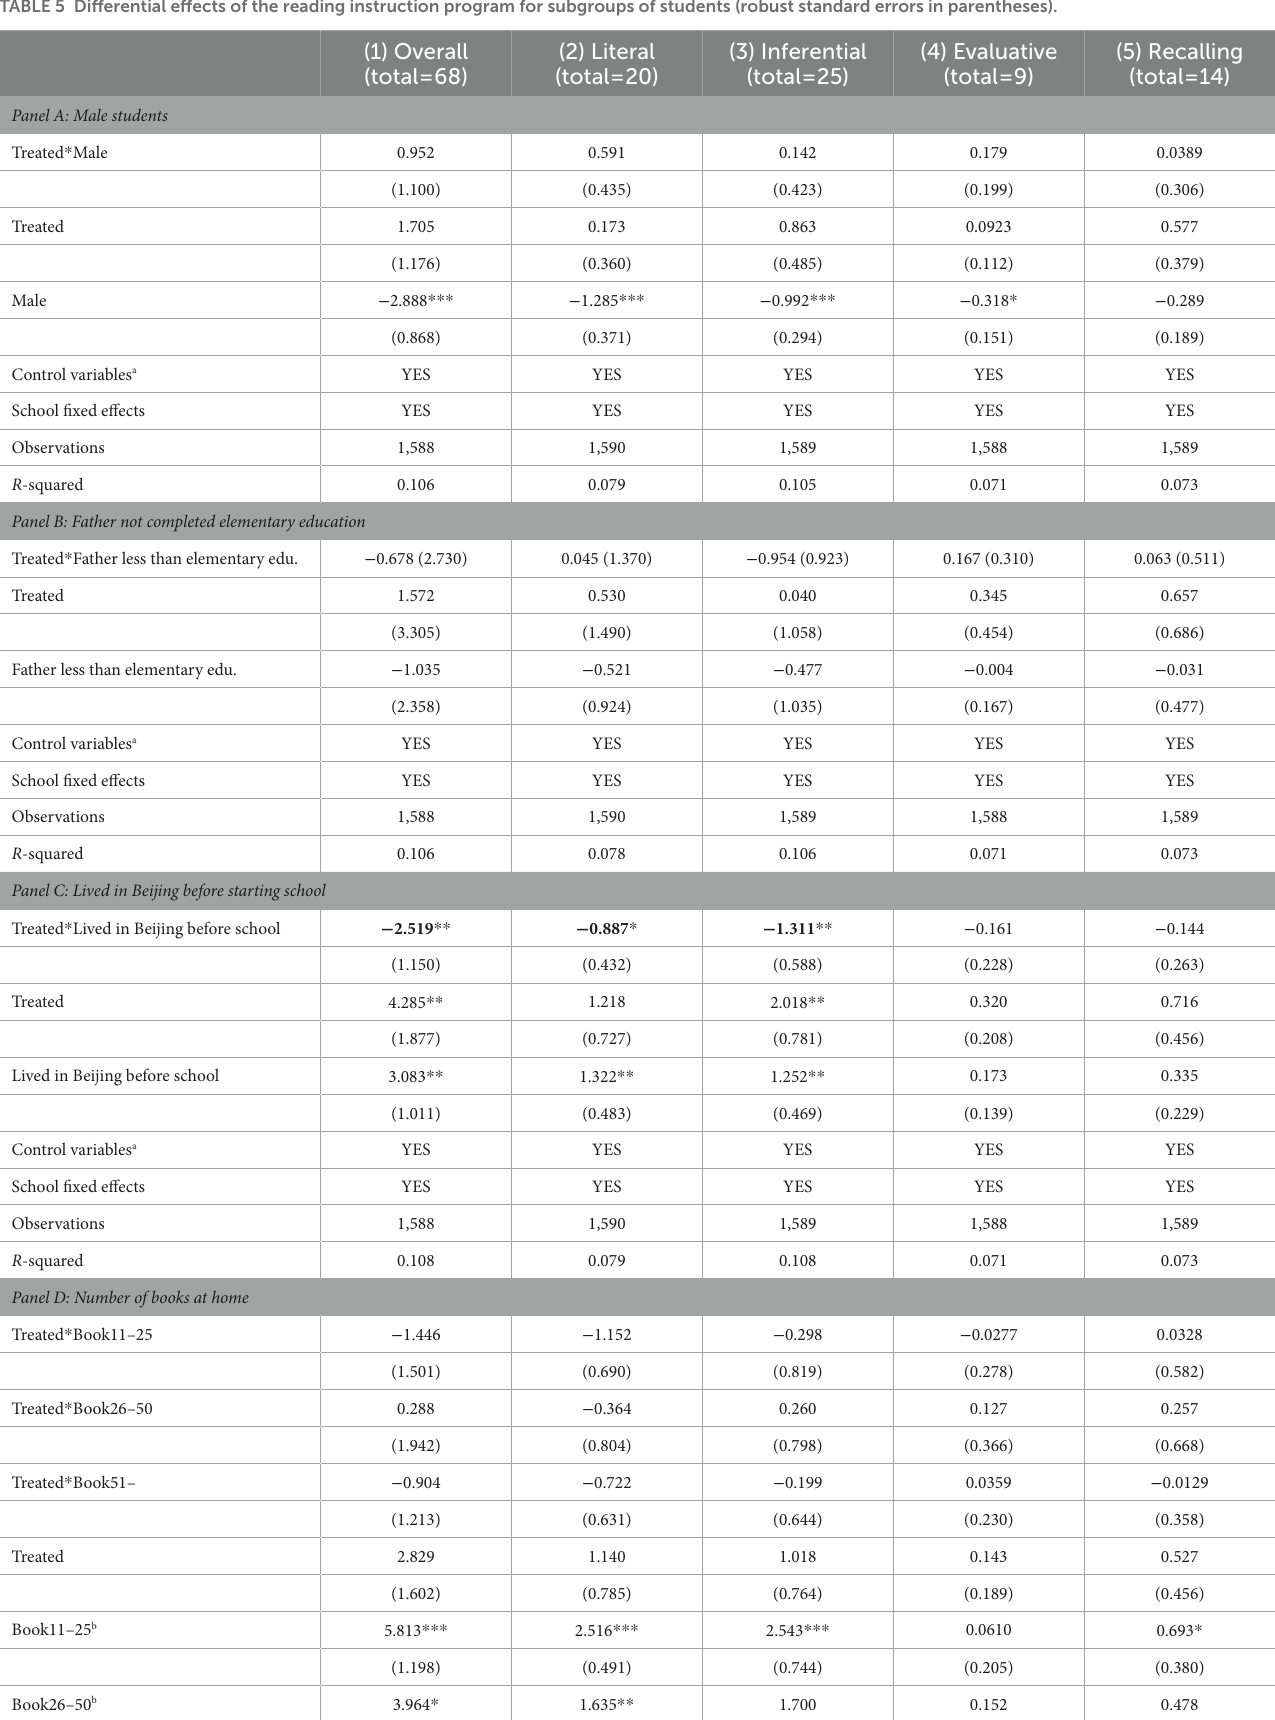
TABLE 5 Differential effects of the reading instruction program for subgroups of students (robust standard errors in